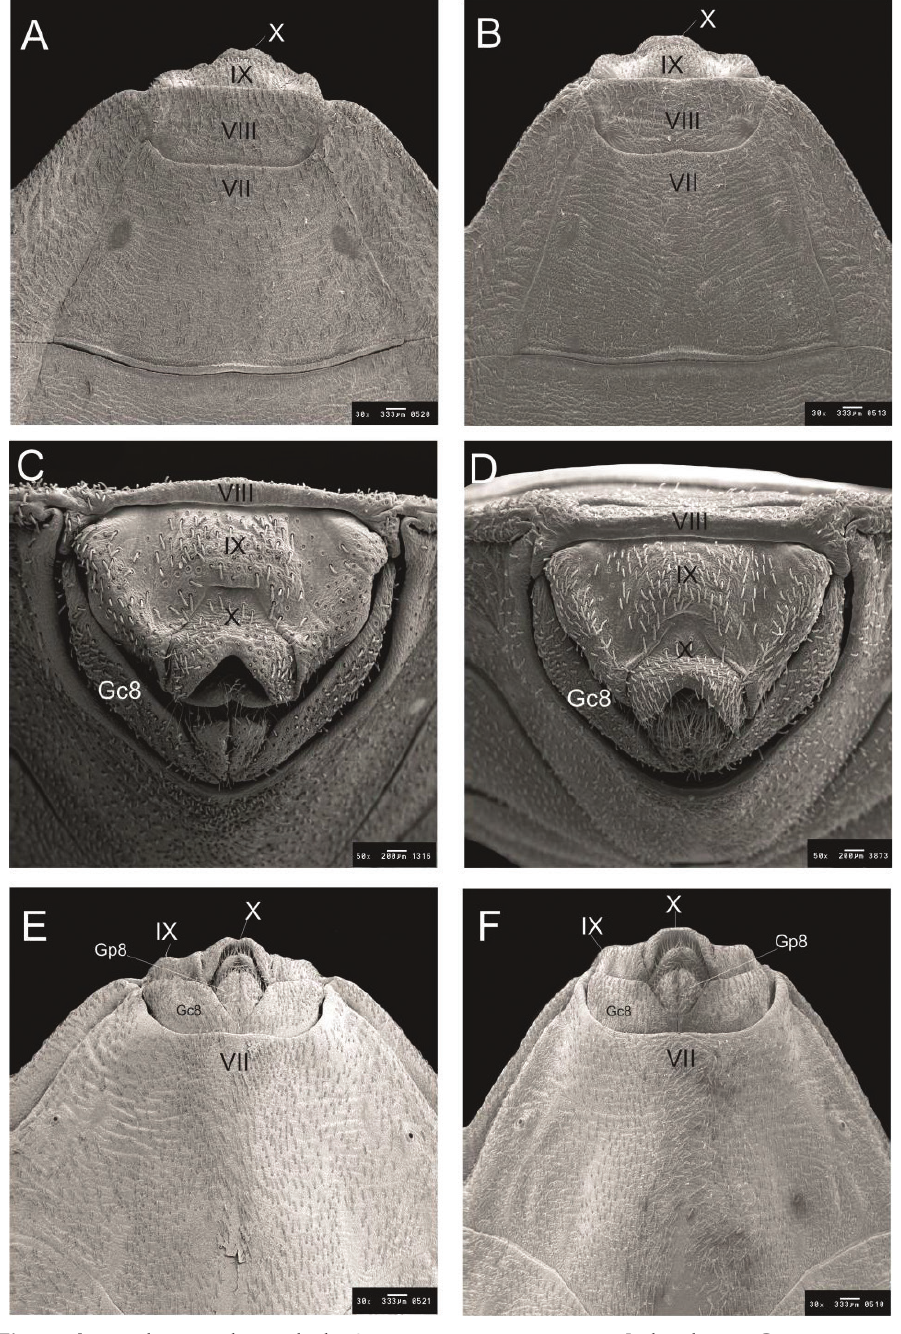
Figure 6. Female external genitalia by SEM R. taquarussuensis sp. n. A dorsal view, C posterior view E ventral view, R. neglectus B dorsal view D posterior view F ventral view. Gc 8: gonocoxite VIII; Gc 9: gonapophyse IX; Gp 8: gonapophyse VIII; VII, IX: tergites; X: